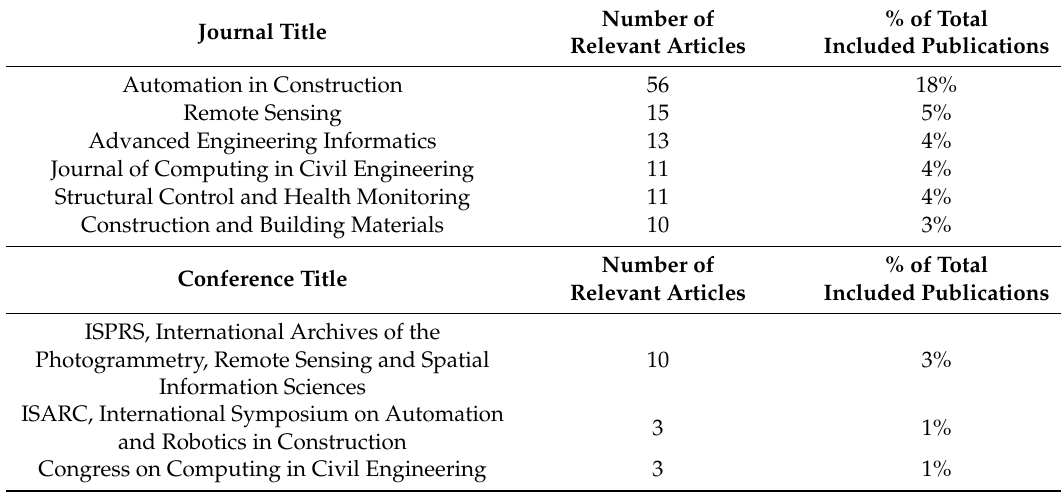
Figure 2. Historical trend of published papers using terrestrial laser scanners (TLS) in all construction industries and bridge engineering